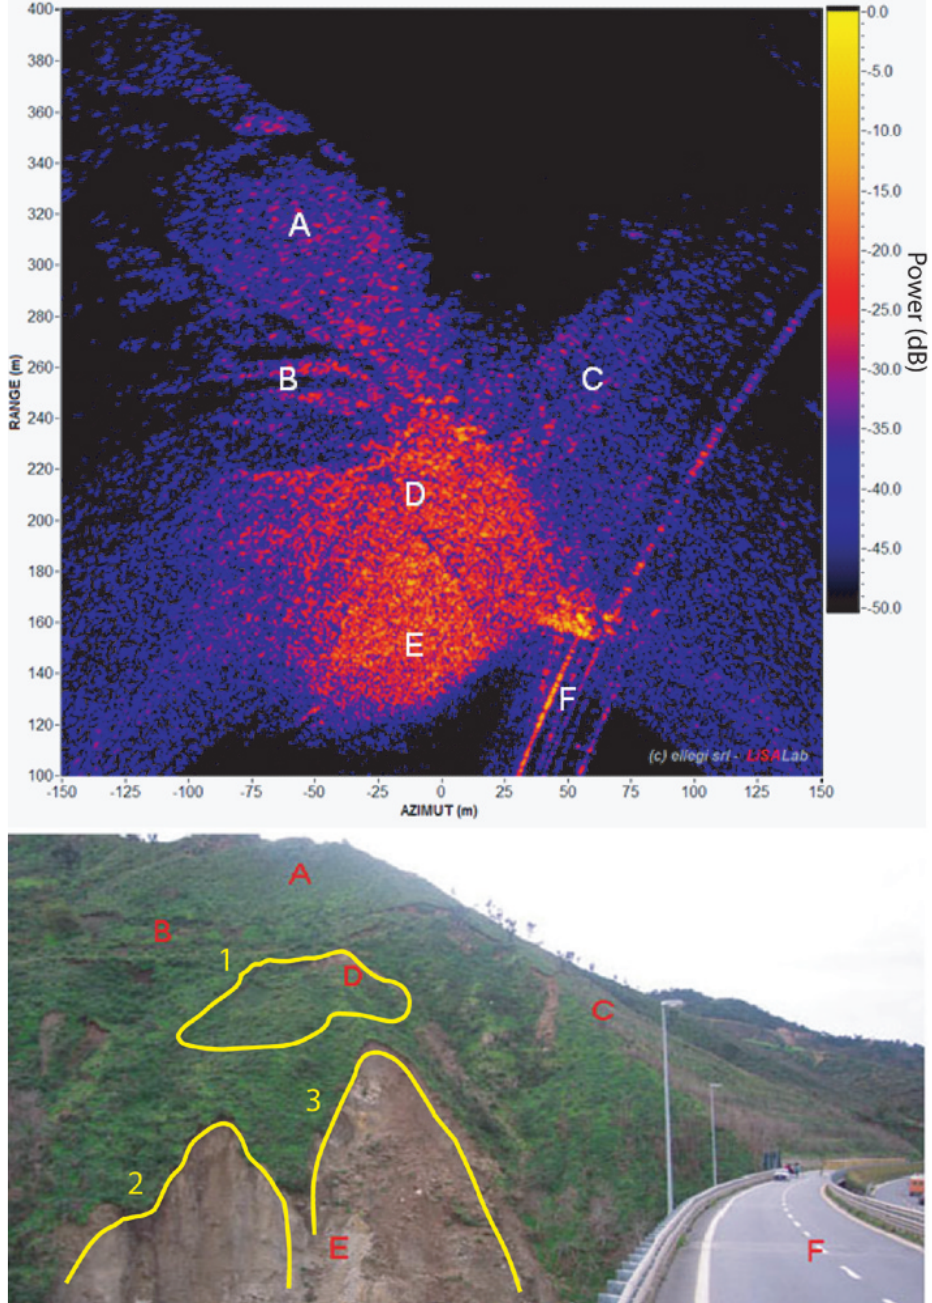
Fig. 6. Power image of Santa Trada landslide (top) compared to a photograph (bottom), both acquired from the radar position. A and B: stable areas; C: NW slope; D and E: unstable areas; F: A3 motorway. Landslide sectors: 1 – top sector; 2 – eastern sector; 3 – western